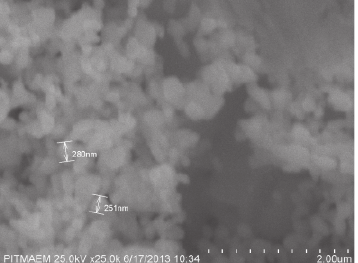
Figure 1: SEM image of silver NPs synthesized by chemical reduction